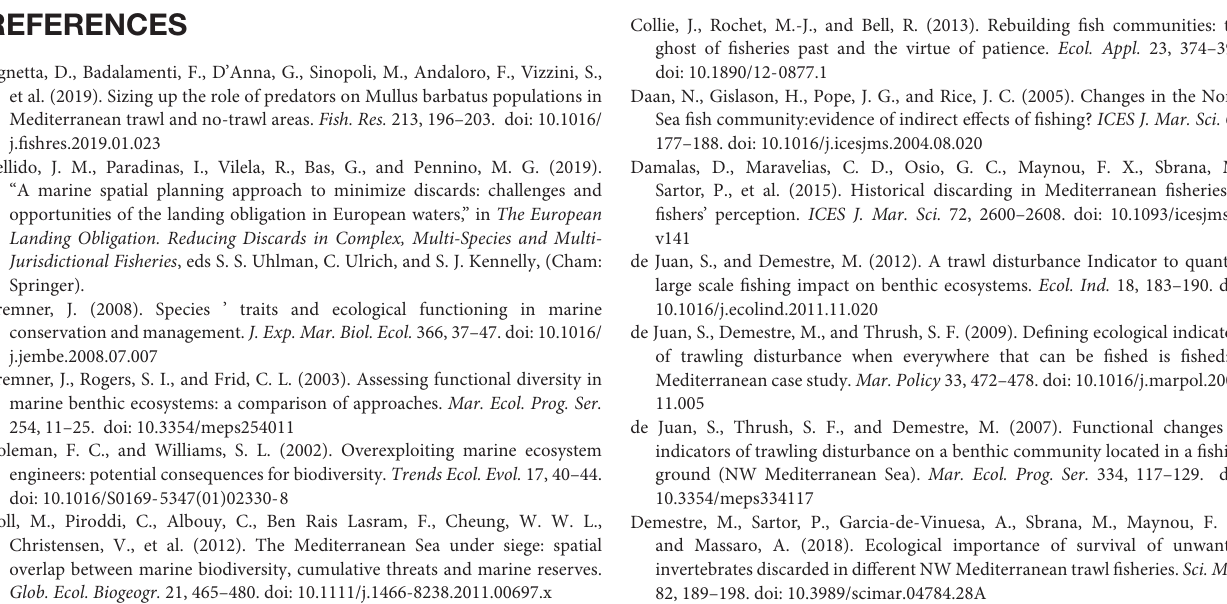
FIGURE S1 | Scatter plot of species that (A) account to 50% of catch biomass in any of the case studies, and (B) have historically declined according to Damalas et al. (2015) and Maynou et al. (2011). Data and species are detailed in Supplementary Tables S5 , S6 . The 3 axes of the plot correspond to x = Catchability, y = Resistance, z = Resilience. Color bar includes the Vulnerability score for each species. Red dot in “Declines” plot overlap 3 very high vulnerability species (see Supplementary Table S6 ). FIGURE S2 | Examples of interaction between environmental factors and biomass distribution amongst index groups. Data is the average of Log (Biomass + 1); data is represented in bars, excluding the standard error in order to illustrate index patterns. Substrate: fine mud (FM), muddy sand (MS), sandy mud-muddy sand (SMMS), sandy mud (SM), sand (S). TABLE S1 | Template to reproduce the vulnerability index including the short species list from the four case studies. TABLE S2 | Full species list recorded in the four case studies. TABLE S3 | Summary of GLM to test the variability in vulnerability level (low, moderate, high, very high) of catch biomass (vulnerability index ∼ Level, family = “quasipoisson”). Test performed for all the species, for the commercial fraction and for the non-commercial fraction. The “%” corresponds to the percentage of explained variance by the model. TABLE S4 | Deviance table from the mvabund test. Variables: biomass of the index’s groups (low, moderate, high and very high). TABLE S5 | Summary of GLM to test the variability in total biomass and total biomass of vulnerable species, % ofvulnerable species in the catch and % of vulnerable species in the catch that are commercialized. TABLE S6 | The most important high vulnerability species (the two species with the highest average biomass in catches within each study area) that were either commercialized or